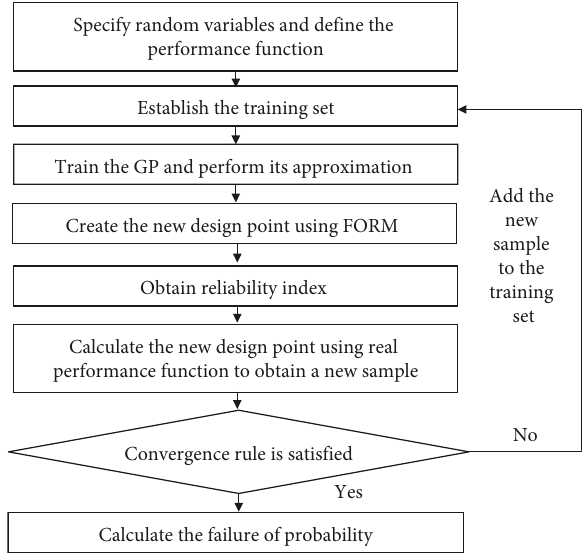
Figure 1: Flow chart of the GP-based